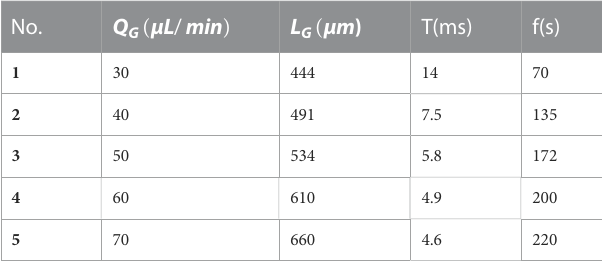
TABLE 4 Generation features of different gas fl ow rate.